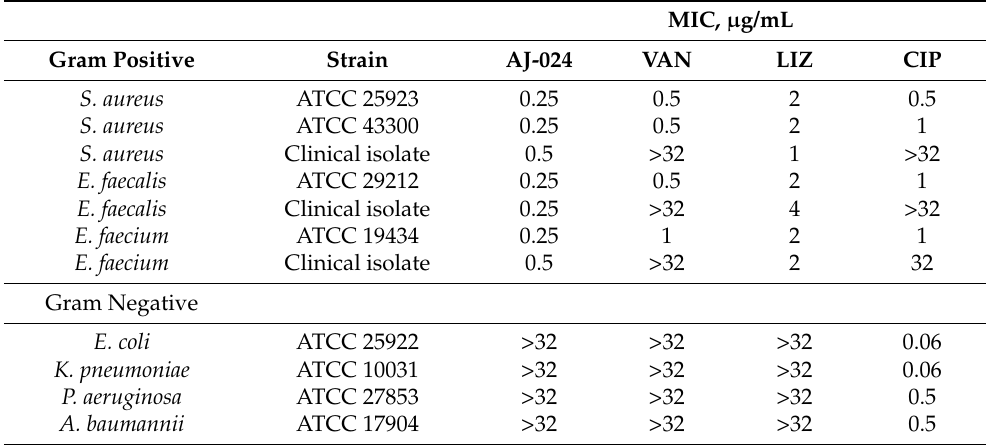
Table 3. AJ-024 (cid:48) s MICs ( µ g/mL) against a panel of clinically important Gram-positive and Gram-negative